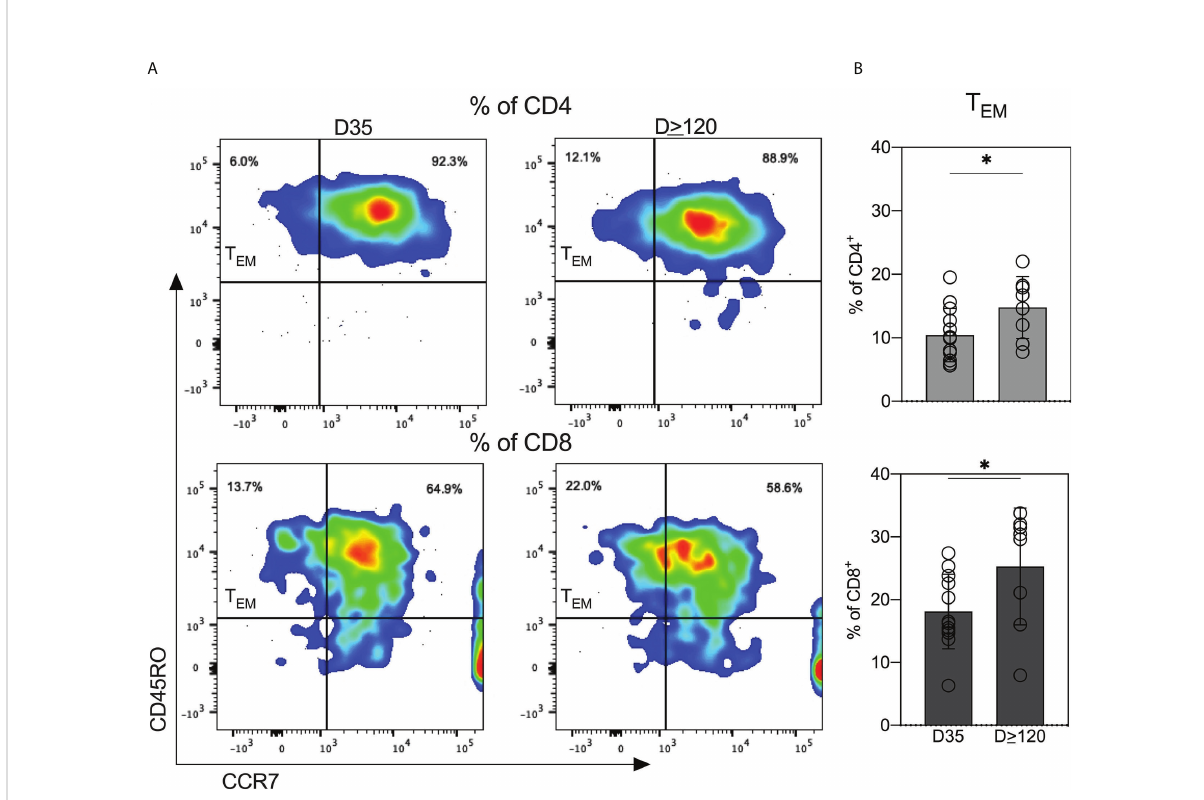
FIGURE 6 Breastmilk obtained from COVID-19-recovered women is enriched for antigen-experienced T cells. (A) Scatter plots from one representative participant showing the distribution of effector memory (T EM ; CD45RO + /CCR7 - ) and central memory (T CM ; CD45RO + /CCR7 - ) T cells in milk provided at the two indicated timepoints. (B) Comparison of T EM within CD4 + and CD8 + T cells between milk obtained at the two indicated timepoints. Independent t tests were performed to analyze differences in T EM expression within CD4 + and CD8 + T cells between the day 35 and day ≥ 120 samples.